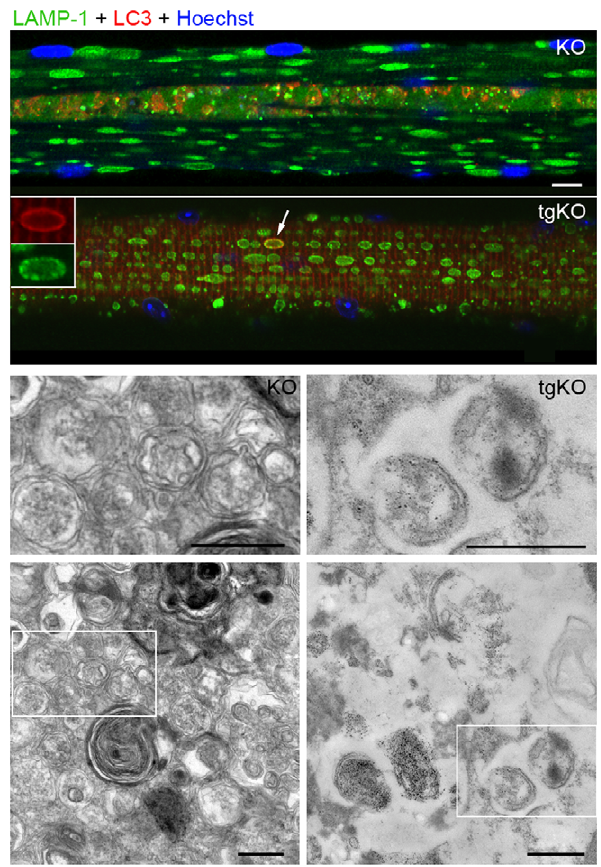
Figure 2. The absence of the autophagic buildup in converted fibers of tgKO. Immunostaining of single psoas (fast) fibers for LAMP- 1 and LC3. A centrally located region with multiple LC3-positive structures, which represents autophagic buildup, is found in the KO, but not in the tgKO fiber. An isolated LC3-positive autophagosome (arrowhead and inset) can be found in the converted fiber from the tgKO. Electron microscopy (B&W panels) shows autophagosomes in psoas fibers in both KO and tgKO mouse lines. Magnification of the areas marked by the white boxes is shown in the upper panels. Muscle samples were taken from 5 month-old mice. Bar: 10 m m (immunoflu- orescence) and 500 nm (EM).